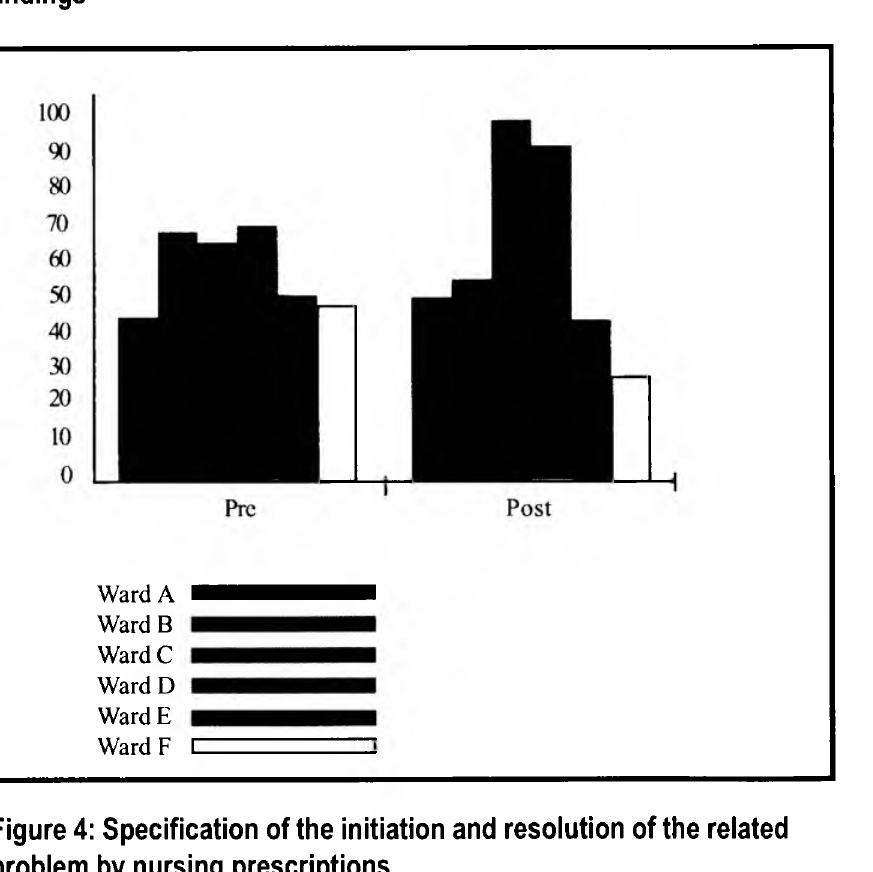
Figure 4: Specification of the initiation and resolution of the related problem by nursing